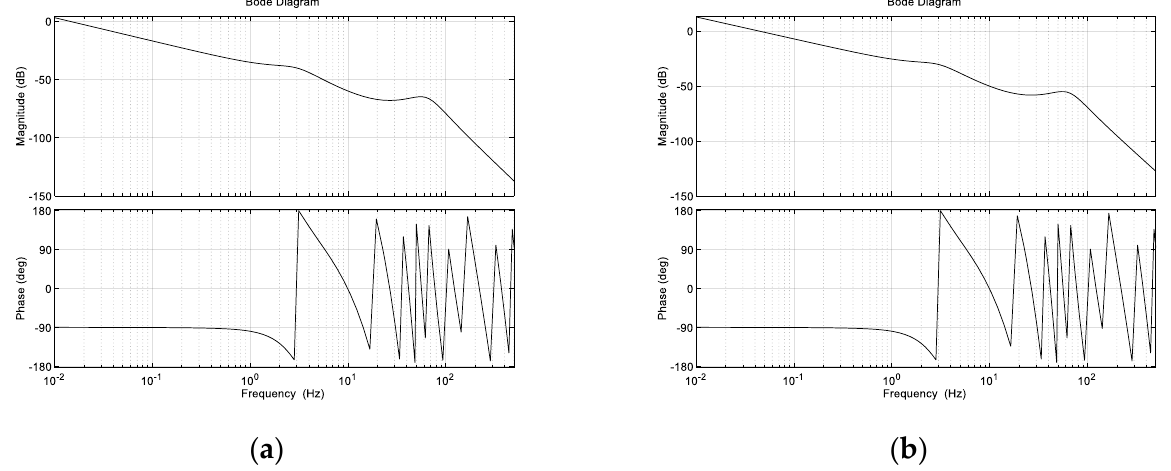
Figure 13. Frequency domain characteristic curve obtained with ( a ) fixed gain control and ( b ) variable gain control techniques.